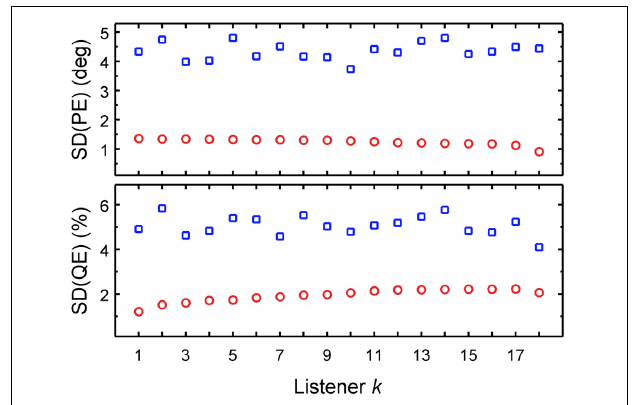
FIGURE 7 | DTF set contributes less than uncertainty to the performance variability of the group. PE SDs and QE SDs as functions of either listener-constant DTF set calculated for listener-specific uncertainties ( U k varied, blue squares) or the listener-constant uncertainty calculated for listener-specific DTF sets (DTF varied, red circles). The abscissa is sorted by the ascending listener-specific uncertainty U k